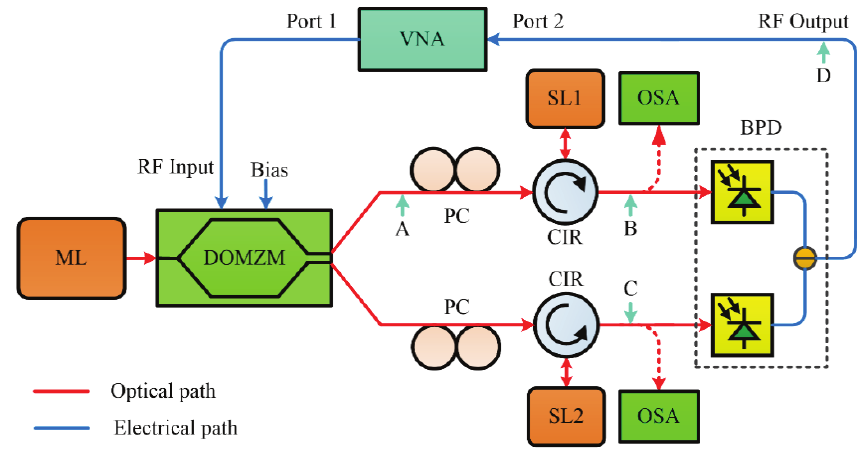
Figure 1. Schematic diagram of the tunable dual-passband microwave photonic filter (MPF). ML: master laser; SL: slave laser; DOMZM: dual-output Mach–Zehnder modulator; CIR: optical circulator; PC: polarization controller BPD: balanced photodetector; VNA: vector network analyzer; OSA: optical spectrum analyzer.